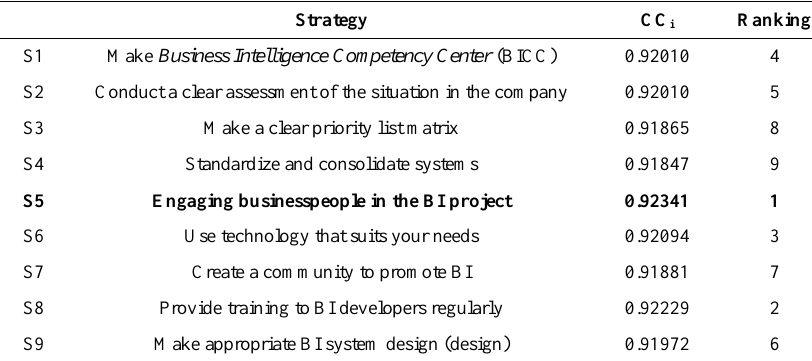
Table 15. Strategy